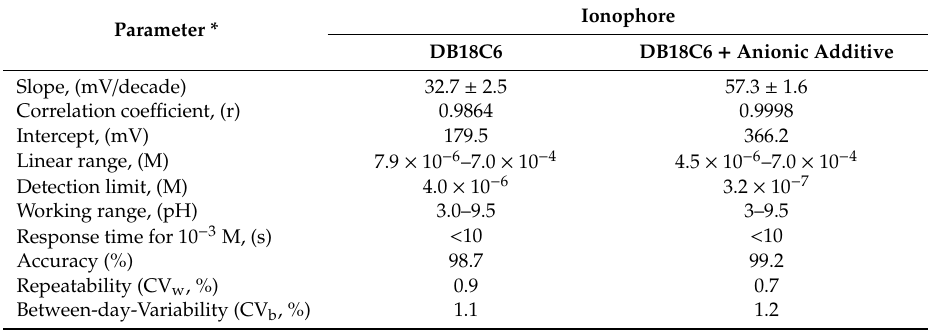
Table 1. Potentiometric response characteristics of Tl + PVC (o,NPOE) membrane sensors based ondibenzo-18-crown-6